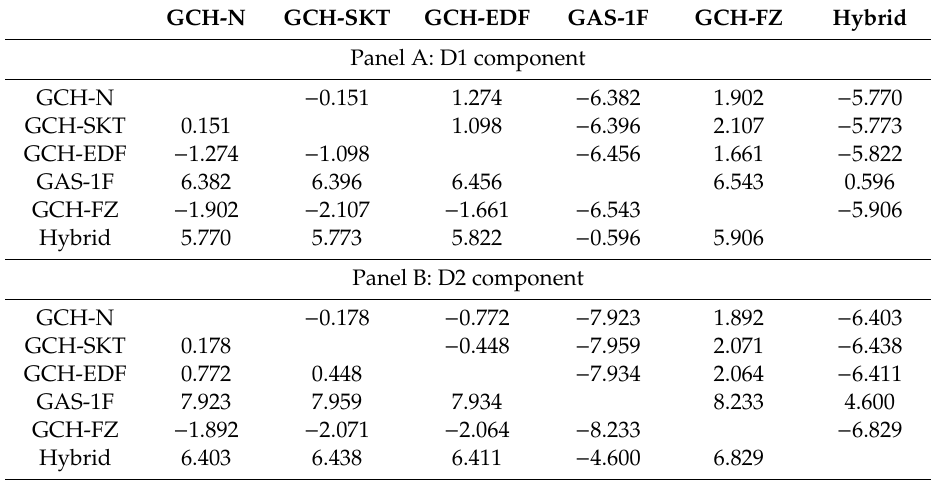
Table 8. The Diebold − Mariano t -statistics for the average out-of-sample loss di ff erences ( α = 0.05, Brent